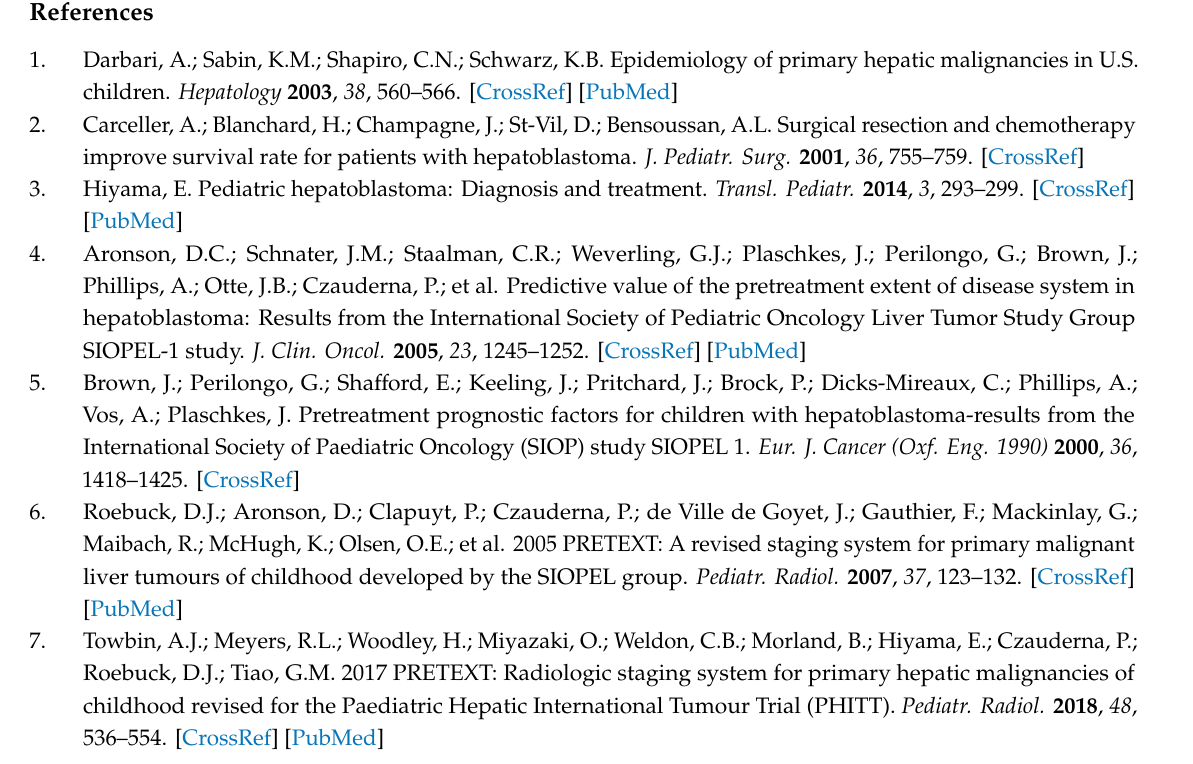
Table S1: 2017 PRETEXT groups and annotation factors, Table S2. Surgical treatment of patients with annotation factors V and P-positive, supplementary figure legend for Figure 2, Figure S1: Clinical course of patients, Figure S2: E ff ect of histologic subtypes on event-free survival, Figure S3: Kaplan-Meier (KM) curves of recurrence-free survival (RFS), Figure S4.: Kaplan-Meier (KM) curves of overall survival